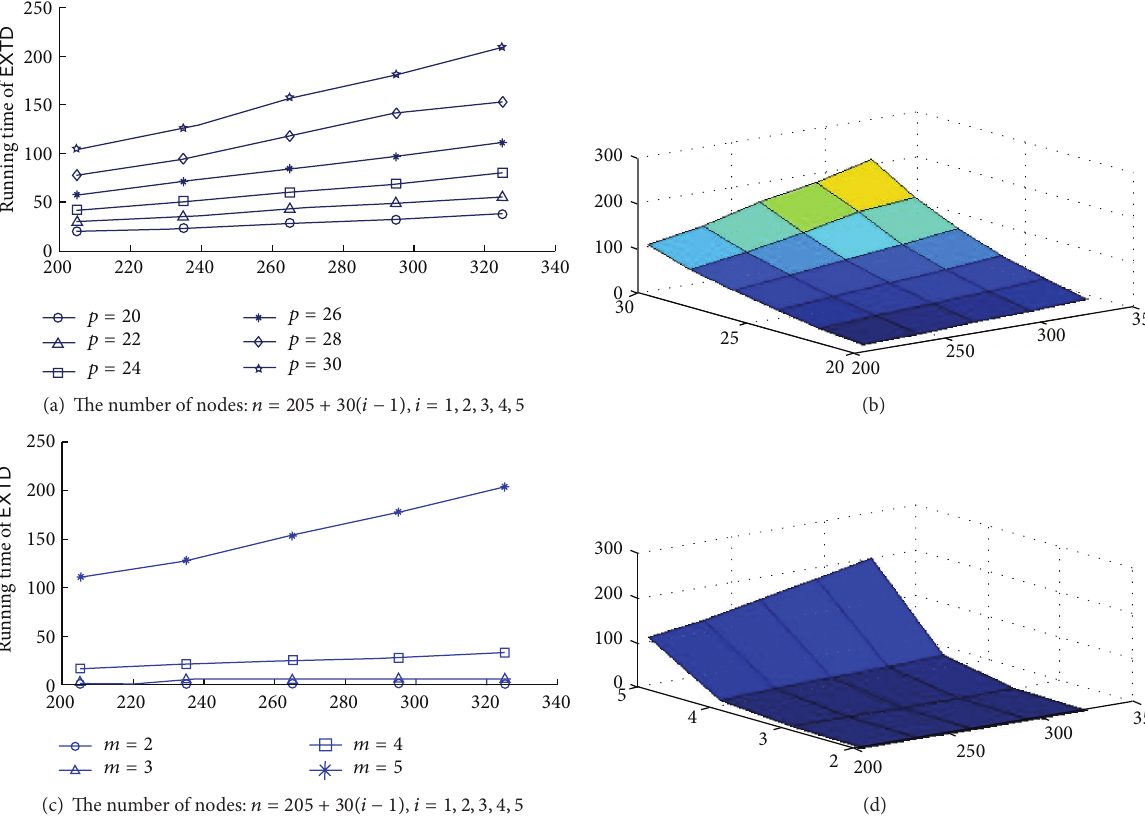
Figure 6: Compare the running times of EXTD for 𝑛 = 205 + 30 × (𝑖 − 1),1 ≤ 𝑖 ≤ 5 and 𝑚 = 2,3, 4, 5 and 𝑝 = 20, 22, 24, 26, 28, 30 .